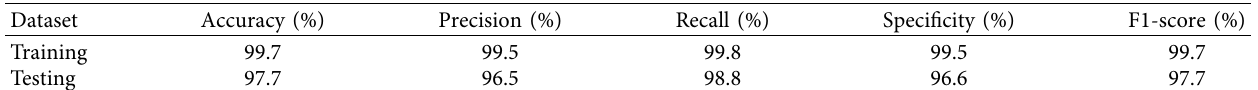
Figure 7: Confusion matrix for (a) the training dataset and (b) the testing dataset. The number of images and the value of quality assessment criteria are also highlighted. Table 4: Values of quality assessment criteria of the CNN